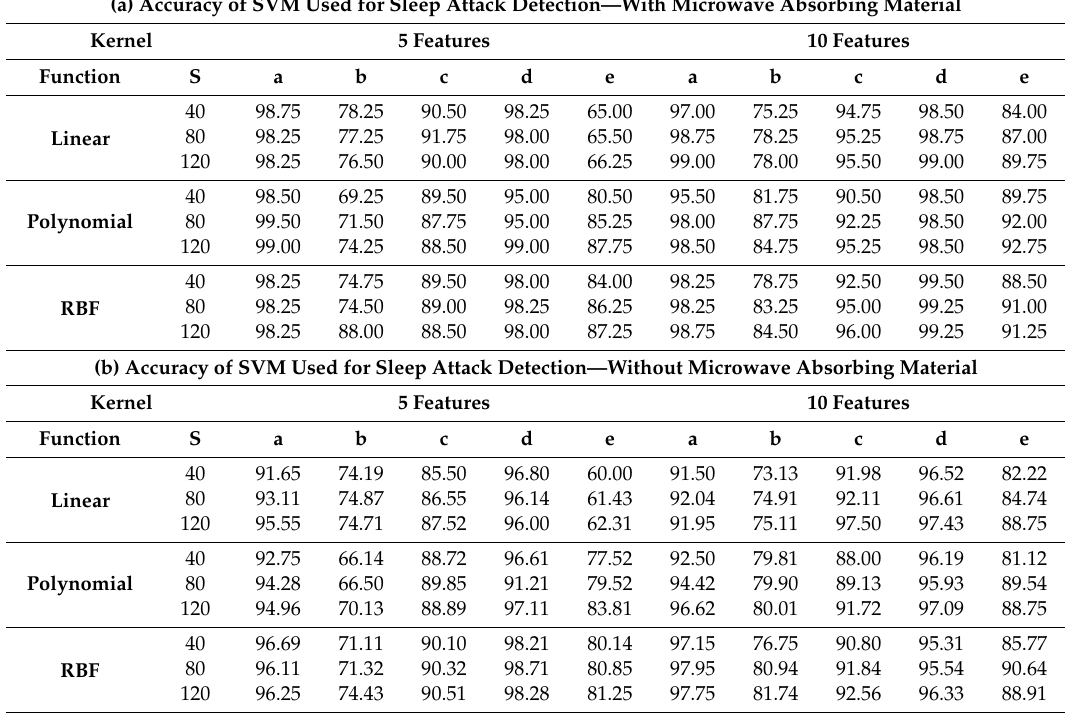
Table 3. Accuracy of SVM used for sleep attack detection (%).